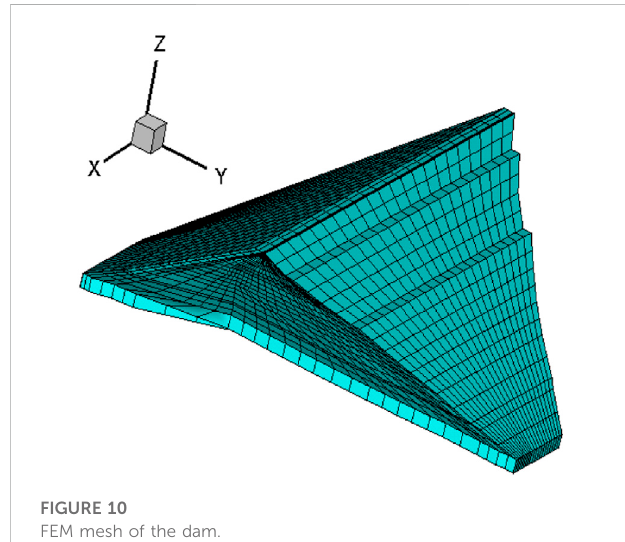
FIGURE 10 FEM mesh of the